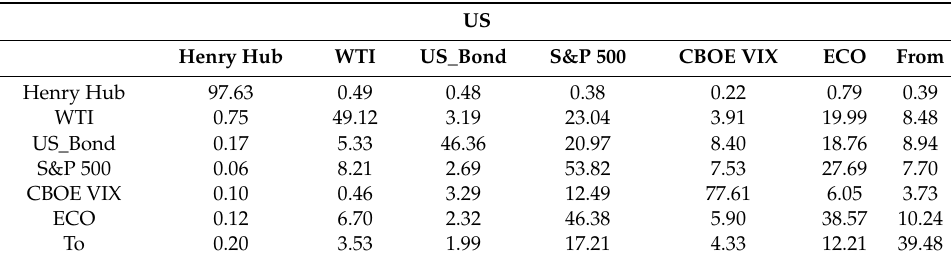
Table A5. Volatility spillover results (US).